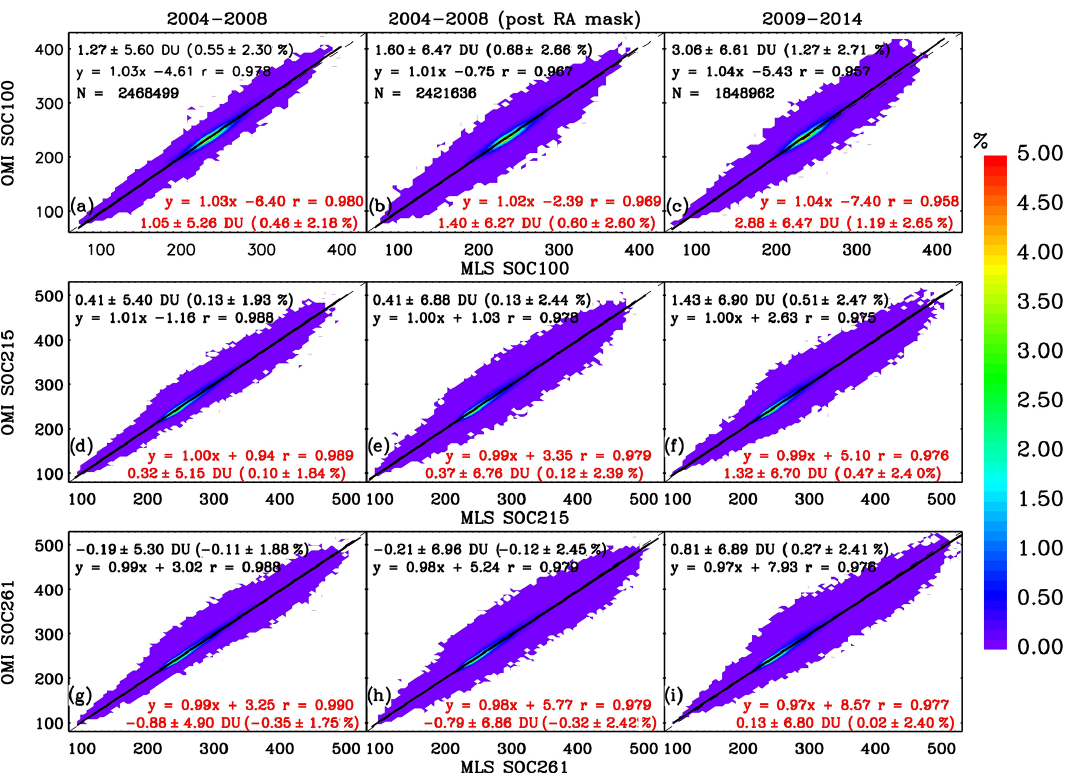
Figure 7. Scattering density plots of OMI and MLS stratospheric ozone columns above 100, 215, and 261hPa (i.e., SOC100, SOC215, and SOC261, respectively), from the top to bottom panels, during 2004–2008 (left), 2004–2008 with post-RA mask (middle column), and 2009–2014 (right). OMI averaging kernels are not applied to MLS data. The comparison statistics of OMI–MLS SOCs are shown in black including mean biases, standard deviations, relative mean biases and standard deviations, correlation coefficients, linear regressions, and the number of OMI–MLS pairs. Comparison statistics with OMI AKs applied to MLS data are also provided in red.